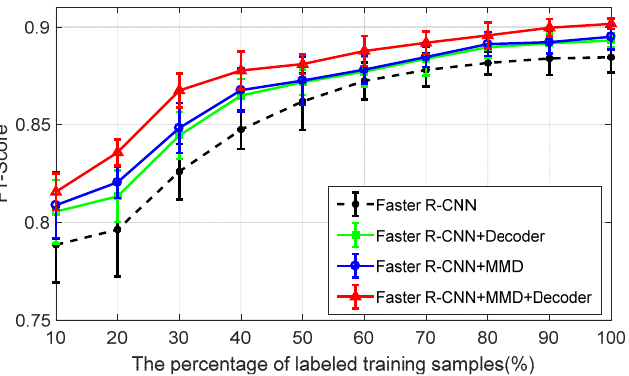
Figure 12. The ablation study results of the F1-scores for our method with different percentages of labeled training samples on the FARADSAR dataset.